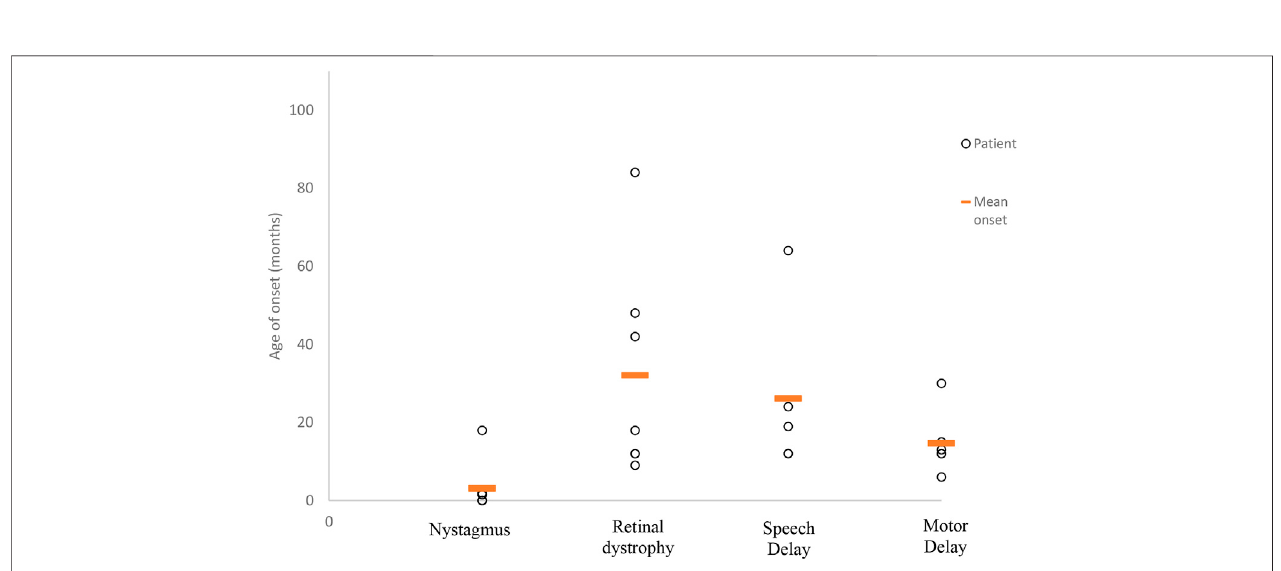
FIGURE2| Averageage at symptomonset. Thisscattergraph illustratesthetimingofsymptomonsetascertained from patientrecords asdocumented. Timingof symptomonsetwasnotidenti fi ableforallclinicalfeatures.Therefore,thoseincludedareasfollows(numberofpatients/meanageofonsetinmonths):nystagmus(6of7/ 3 months), retinal dystrophy (7 of 9/32 months), speech delay (5 of 9/26 months), and motor delay (6 of 9/15